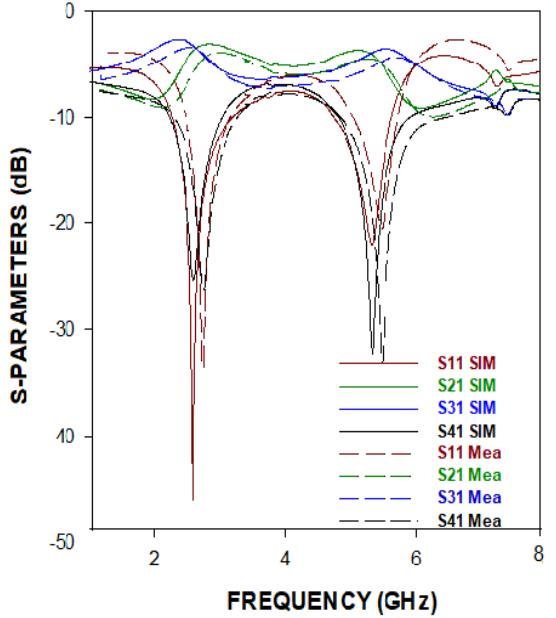
Fig.10. Proposed dual-band patch coupler simulation and measurement results